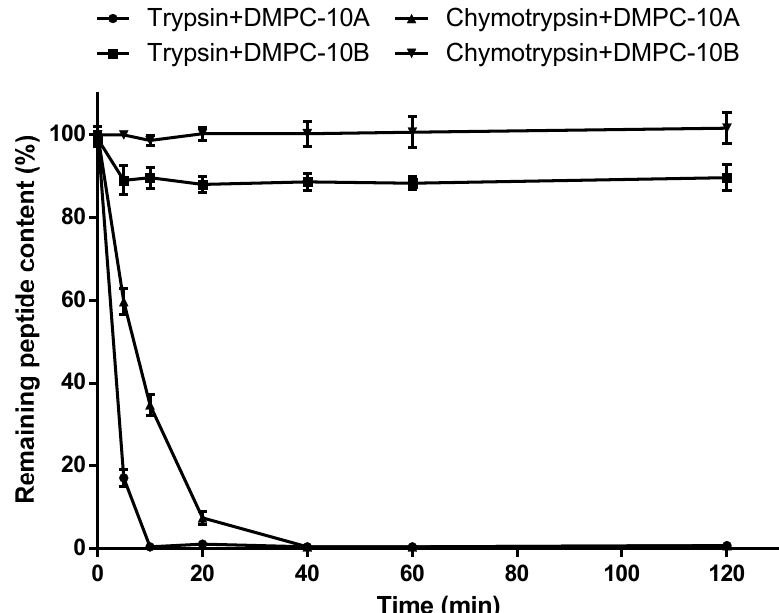
Figure 3. The amount of intact peptides of DMPC-10A and DMPC-10B undergoing in vitro hydrolysis by trypsin and chymotrypsin in 120 min. The error bar represents the standard deviation (SD) of three replicates.